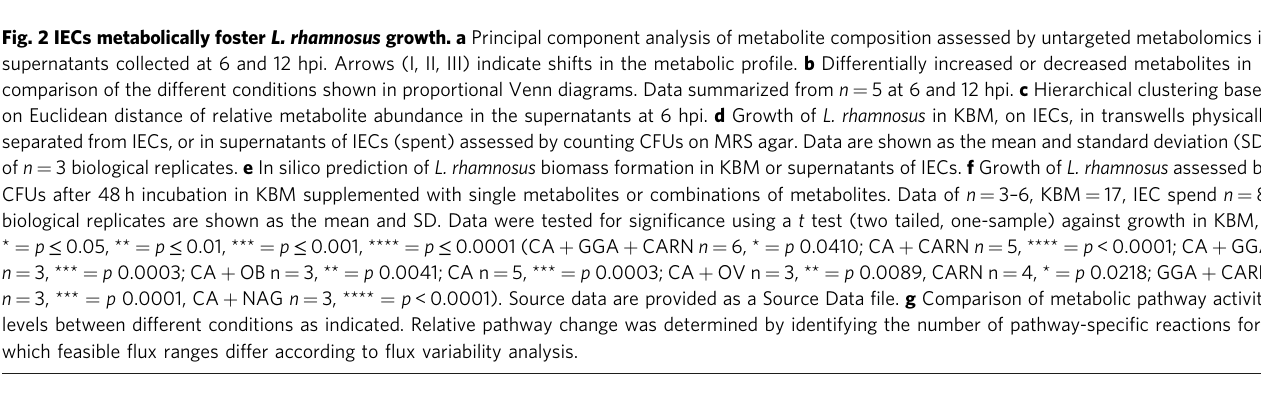
Fig. 2 IECs metabolically foster L. rhamnosus growth. a Principal component analysis of metabolite composition assessed by untargeted metabolomics in supernatants collected at 6 and 12 hpi. Arrows (I, II, III) indicate shifts in the metabolic pro fi le. b Differentially increased or decreased metabolites in comparison of the different conditions shown in proportional Venn diagrams. Data summarized from n = 5 at 6 and 12 hpi. c Hierarchical clustering based on Euclidean distance of relative metabolite abundance in the supernatants at 6 hpi. d Growth of L. rhamnosus in KBM, on IECs, in transwells physically separated from IECs, or in supernatants of IECs (spent) assessed by counting CFUs on MRS agar. Data are shown as the mean and standard deviation (SD) of n = 3 biological replicates. e In silico prediction of L. rhamnosus biomass formation in KBM or supernatants of IECs. f Growth of L. rhamnosus assessed by CFUs after 48 h incubation in KBM supplemented with single metabolites or combinations of metabolites. Data of n = 3 – 6, KBM = 17, IEC spend n = 8 biological replicates are shown as the mean and SD. Data were tested for signi fi cance using a t test (two tailed, one-sample) against growth in